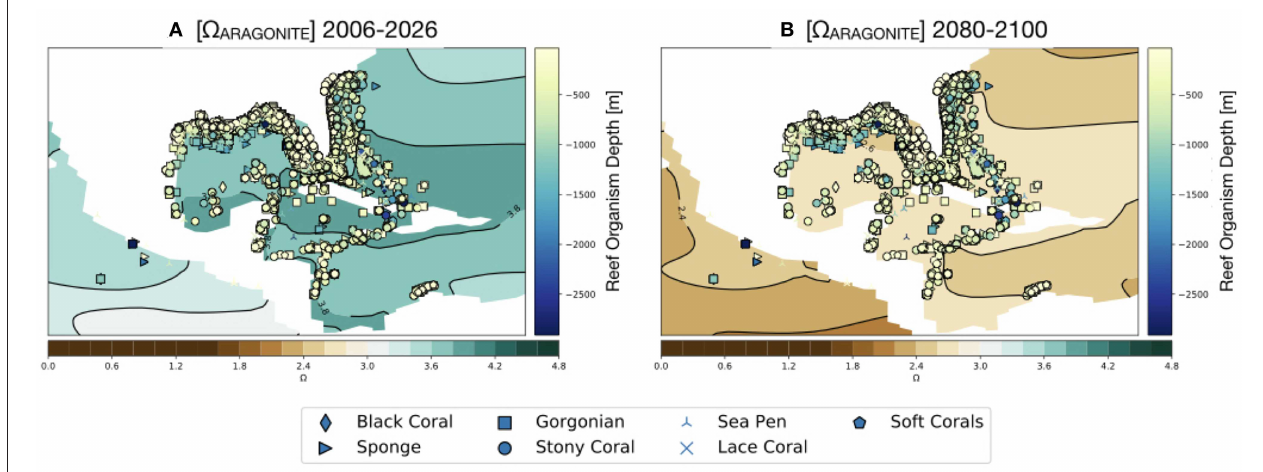
FIGURE 9 | Simulated values of (cid:127) aragonite for the GoMand northern Caribbean region in the RCP8.5 Large Ensemble (CESM1.2) in the surface ocean (0–50 m). Reef organisms and depth at which they occur [m] overlain (see Figure 1 ). (A) 2006–2026 mean, (B) 2080–2100 mean. Continental regions are shown in white.